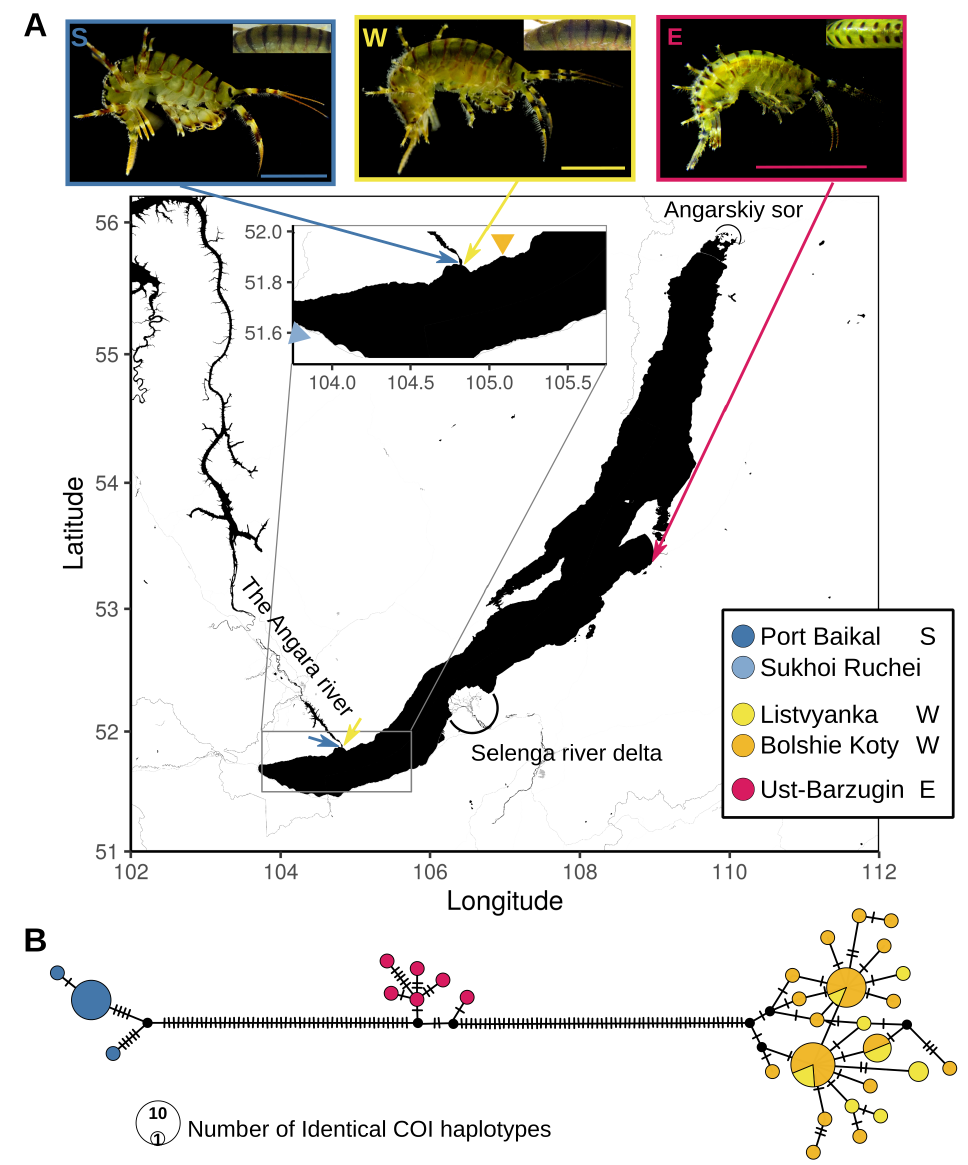
Figure 1. Typical morphology, sampling locations, and molecular diversity of the three (pseudo)cryptic species within E. verrucosus . ( A ) Typical morphology of the three species and sampling locations of the specimens used in this work. Samples for flow cytometry and crossing experiments were collected at the locations indicated with colored arrows (blue, Port Baikal (S); yellow, Listvyanka (W); magenta, Ust-Barguzin (E)). An additional orange triangle arrowhead marks Bolshie Koty, the point of origin for the published transcriptome samples for the western species, while additional blue arrowhead marks Sukhoi Ruchei, the sampling point for the published E. vittatus and E. cyaneus mitochondrial genomes. The presumable geographic borders between the ranges are labeled. Insets: photographs of a typical representative of each species. All scale bars in the photographs are 10 mm. The S and W photos were taken with an Olympus Tough TG-5 digital camera under ceiling illumination, while the E photo was taken under an Altami SPM0880 microscope with side illumination and this seems slightly brighter. In all cases, color correction was performed using the same 17% gray paper. ( B ) COI haplotype networks of E. verrucosus individuals from the same locations based on the data published earlier [38]. A TCS network [63] is shown built with popart [64] v1.7 from the alignment of COI sequences of the corresponding samples [38]. Each hatch mark corresponds to one nucleotide